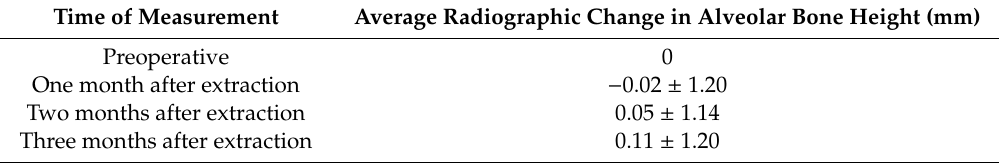
Table 6. Variation in radiographic alveolar height by time of